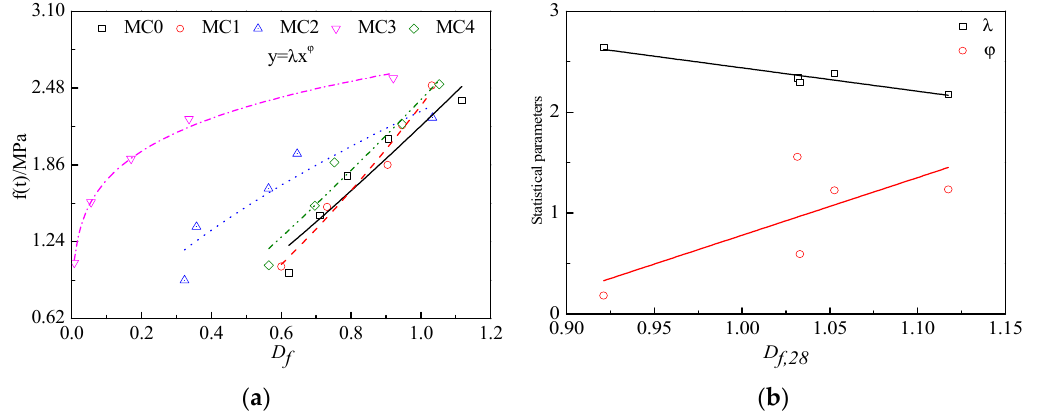
Figure 9. The relationship between tensile strength of NCM and statistical parameters and D f :( a ) f ( t ) with D f ; ( b ) statistical parameters with D f ,28.